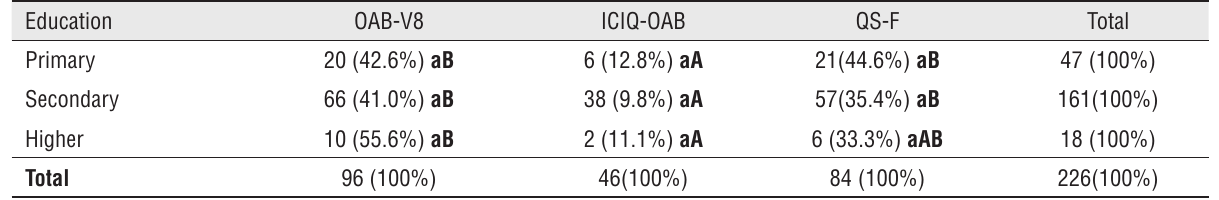
Table 3 - number and percentage of women considering ease to answer the different questionnaires according to educational levels. Education